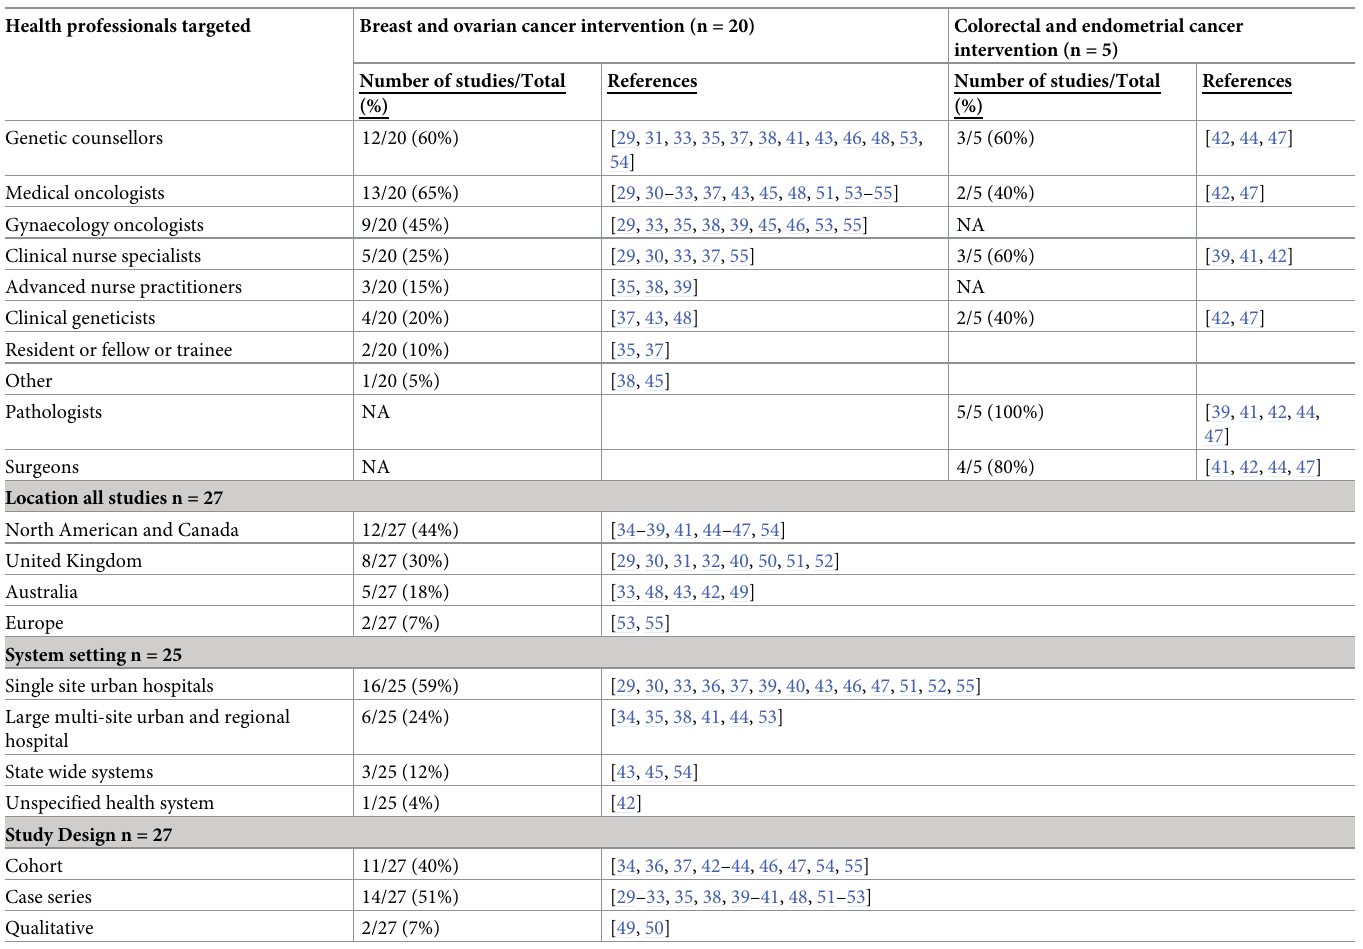
Table 2. Summary of included studies and participants’